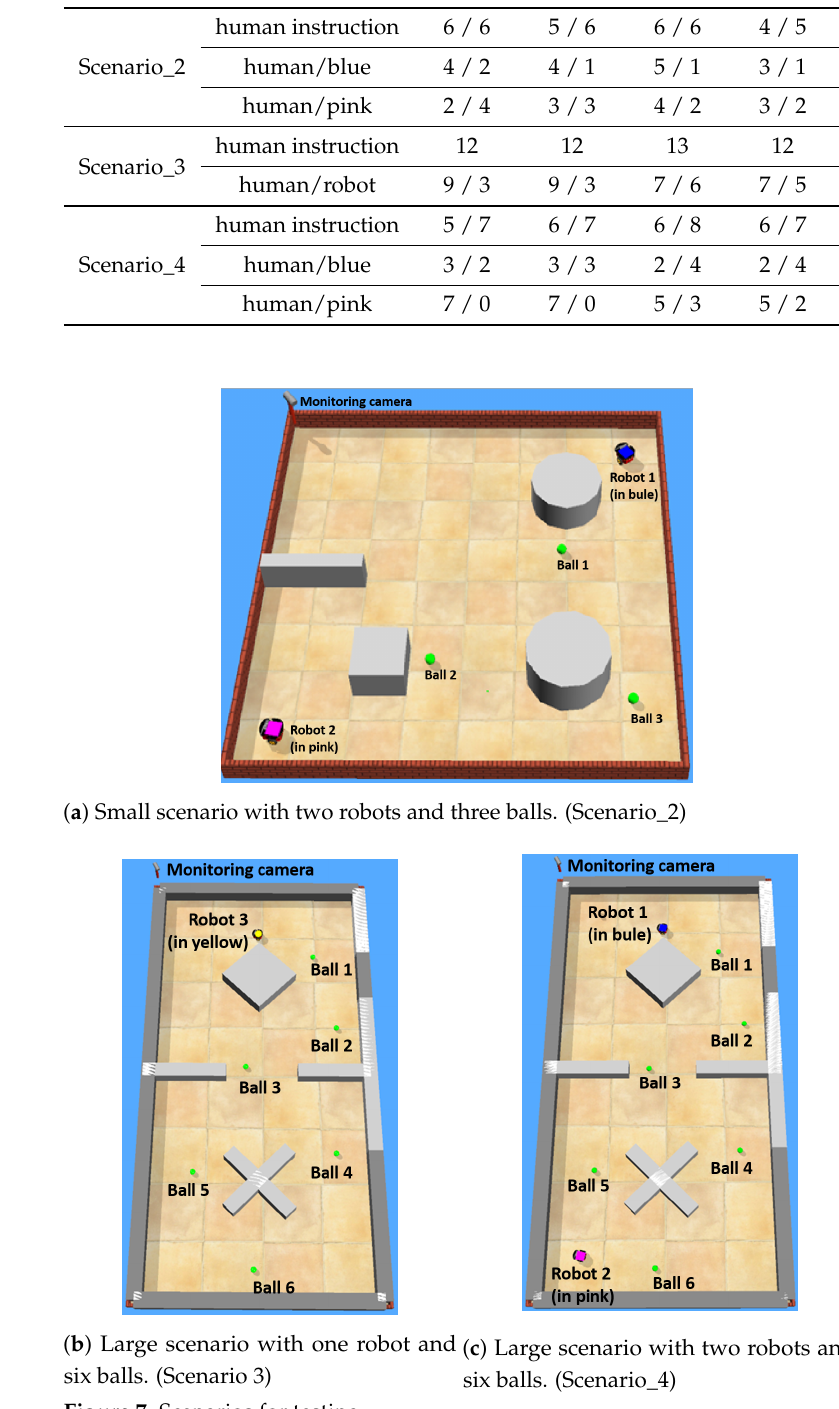
Figure 7. Scenarios for